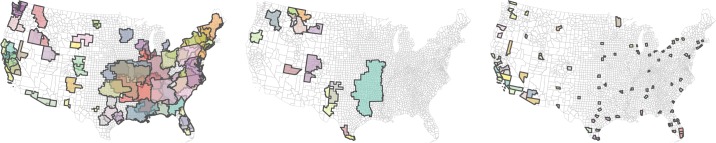
Resulting communities from the CCME-SL algorithm.Communities (non-nodal) (left), nodal clusters (middle), and monads (right).